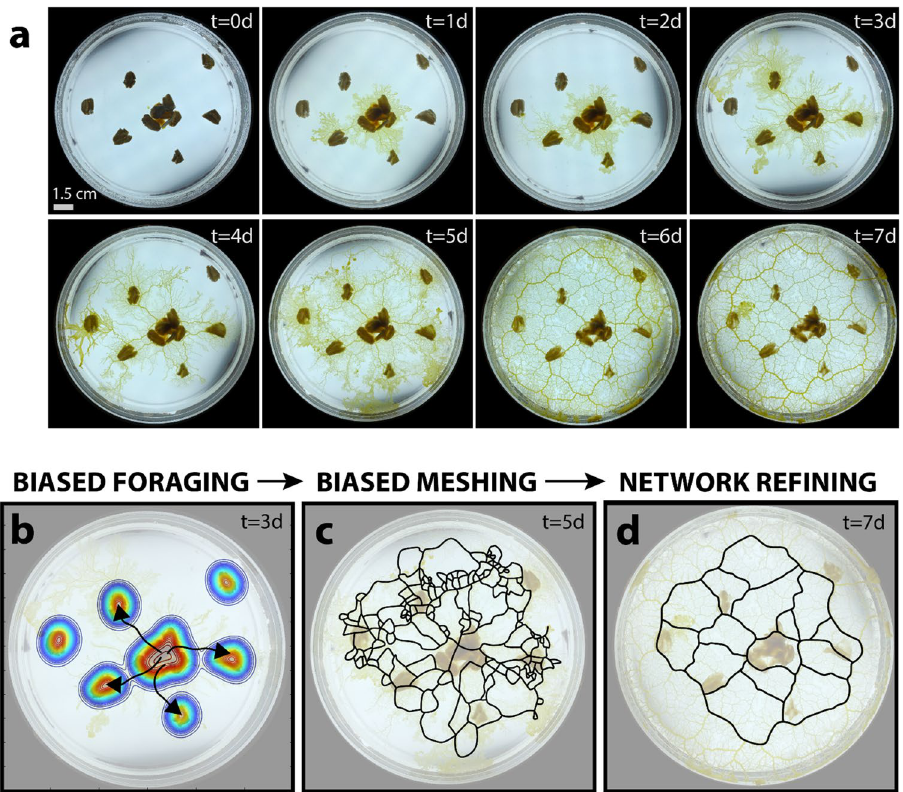
Figure 2. Simplified principles of plasmodial Physarum polycephalum growth. ( a ) Growth of the plasmodium across seven-day observation period. ( b ) Illustrated depiction of plasmodial growth according to food source proximity. This behaviour leads to mesh clustering (phase one). ( c ) Illustrated depiction of mesh clustering, with mesh regions illustrated. ( d ) Illustrated depiction of network refinement and shortest-path optimization (phase two), where only a refined network remains and is illustrated. Illustrations overlaid atop true